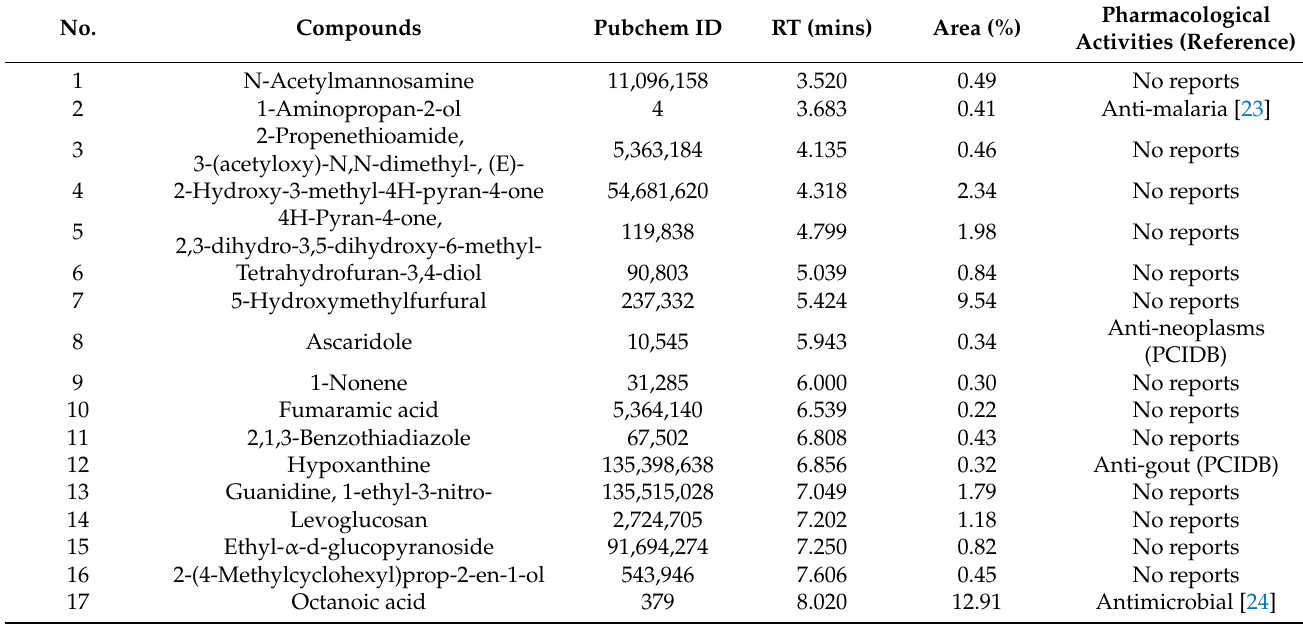
Table 1. A list of 52 chemical compounds identified from ICLs via GC-MS and profiling of biological activities.